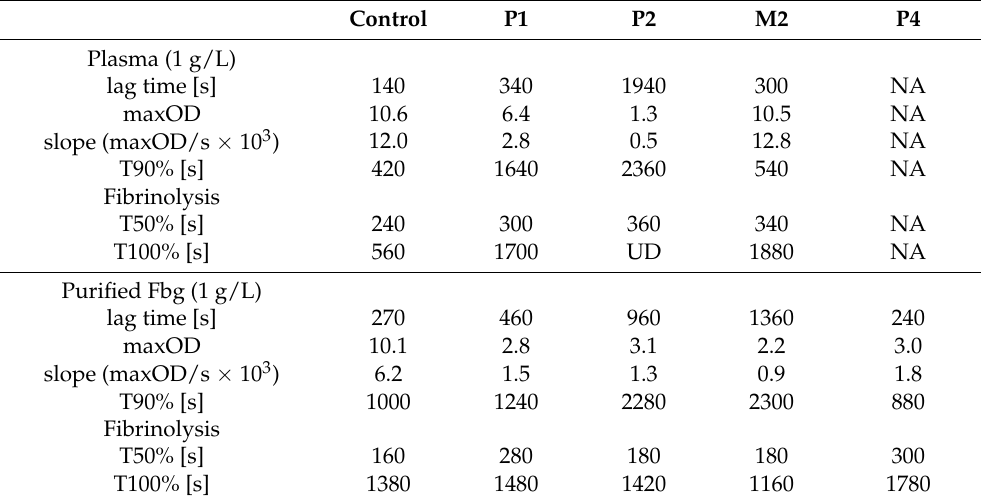
Table 2. Plasma and purified fibrinogen polymerization of each patient and